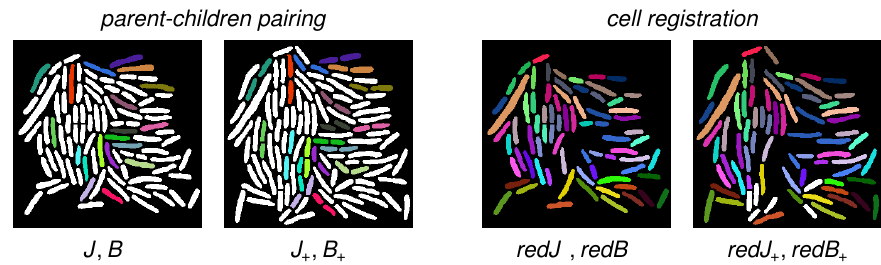
Figure 7. Cell tracking results for the pair COL1 of successive images J , J + shown in Figure 6. The in- terframe duration is six minutes. ( Left ): Results for parent–children pairing on COL1. Automatically detected parent–children triplets are displayed in the same color. ( Right ): Computed registration. The removal of the automatically detected parent–children triplets (see left column ) generates the reduced cell sets redB and redB + . Automatic registration of redB and redB + is again displayed via identical color for the registered cell pairs ( b , b + ) . Mismatches are mostly due to previous errors in parent–children pairing (see Figure 8 for a more detailed